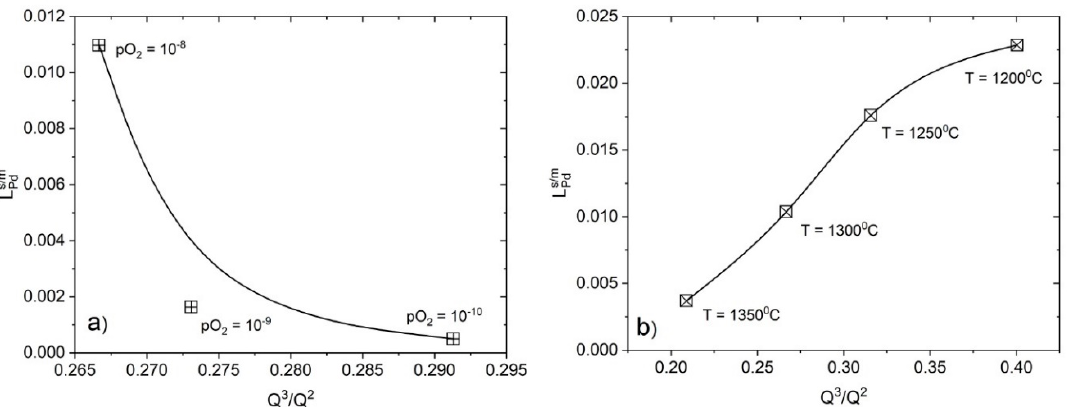
(cid:2900)(cid:2914)(cid:2929) (cid:2923)⁄ ) in FCSM-Cu 2 O-PdO slags at: ( a )